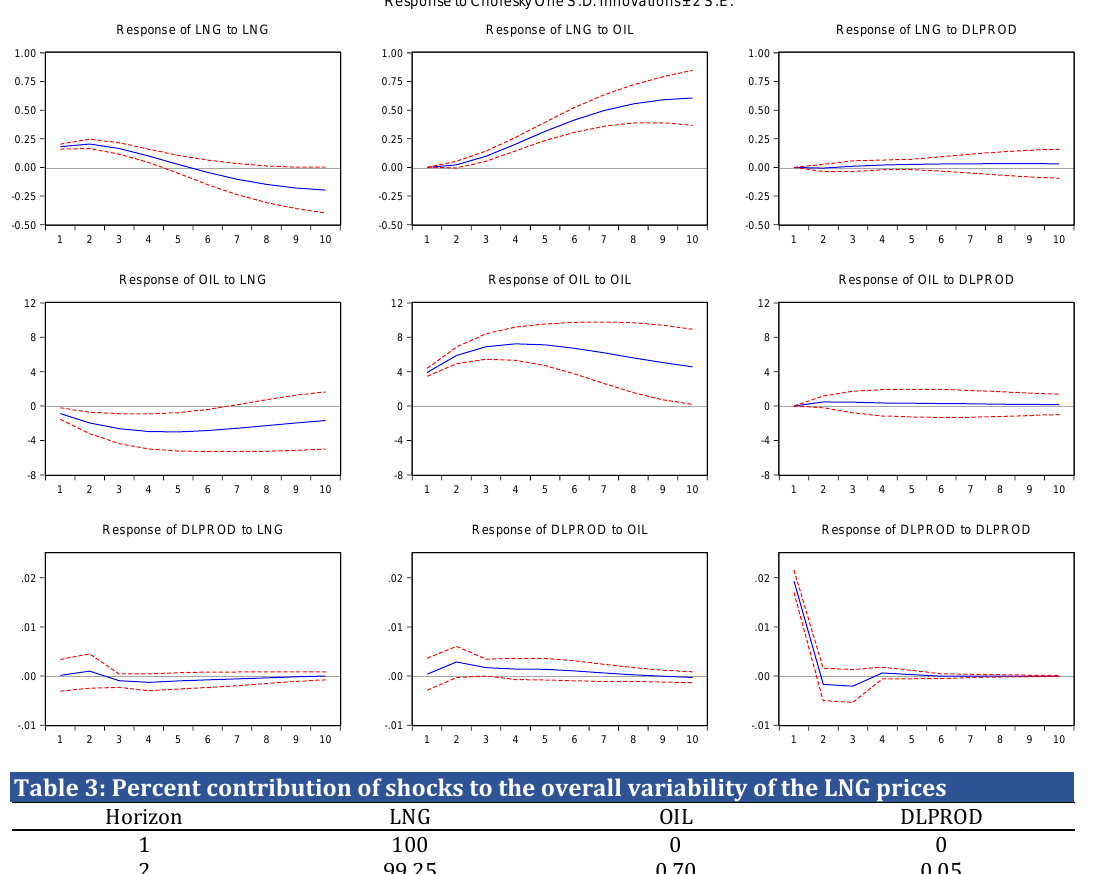
Figure 2: Impulse responses of structural shocks to LNG prices, 1997-2008